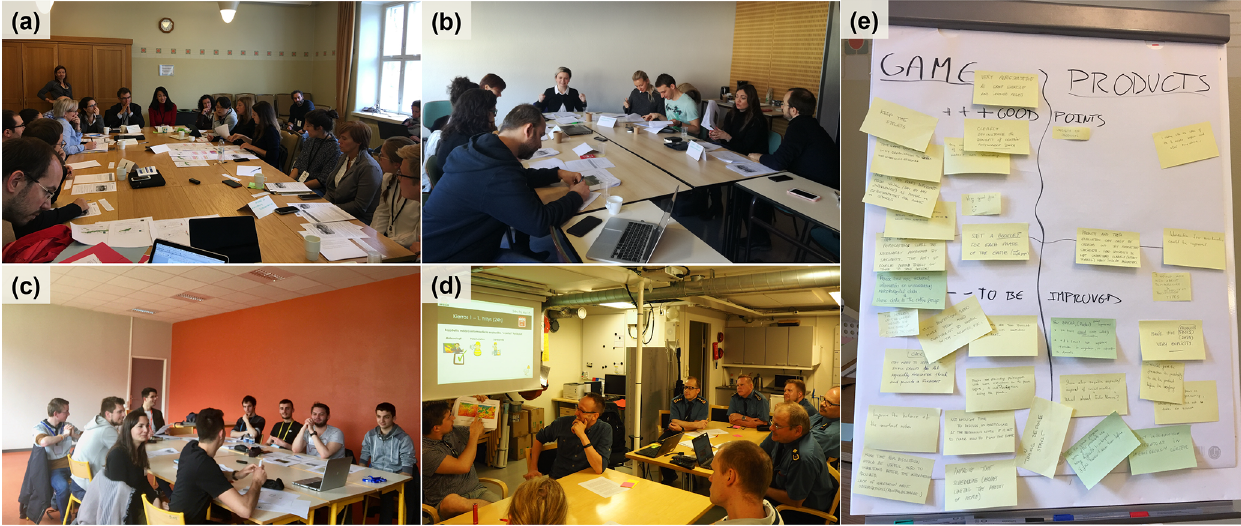
Figure 4. From (a) to (d) : players debate during the role-playing simulations of ANYCaRE in (a) the Helsinki experiment (21 Septem- ber 2017), (b) the Grenoble experiment (24 January 2018), (c) the UGA experiment (11 April 2018) and (d) the Mikkeli experiment (17 May 2018). (e) Example of players’ post-experiment debriefing post-it notes (photo taken in the Helsinki